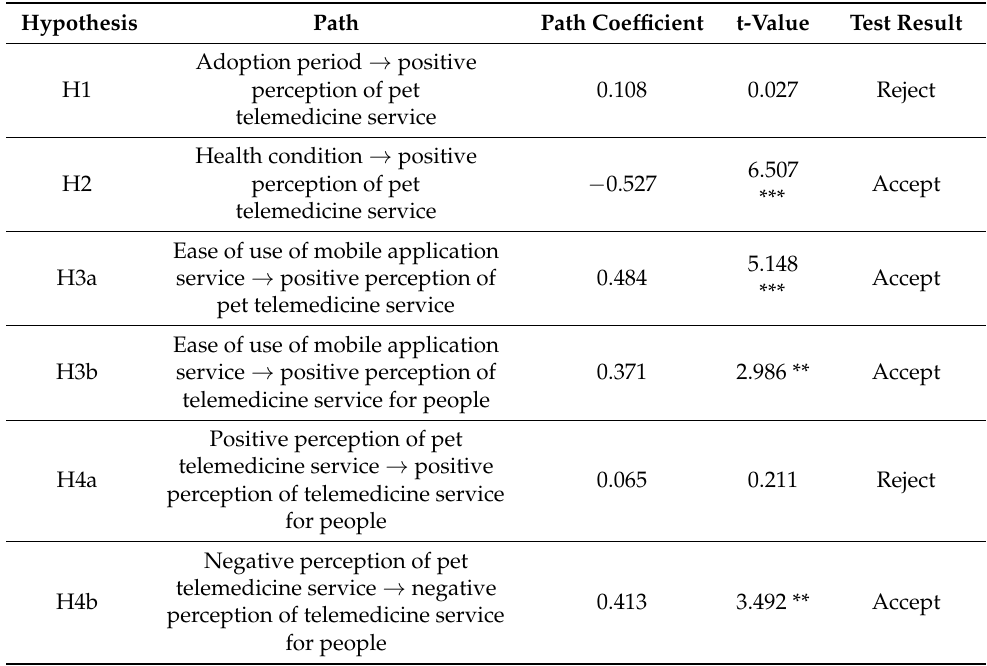
Table 7. Result of hypotheses test with path